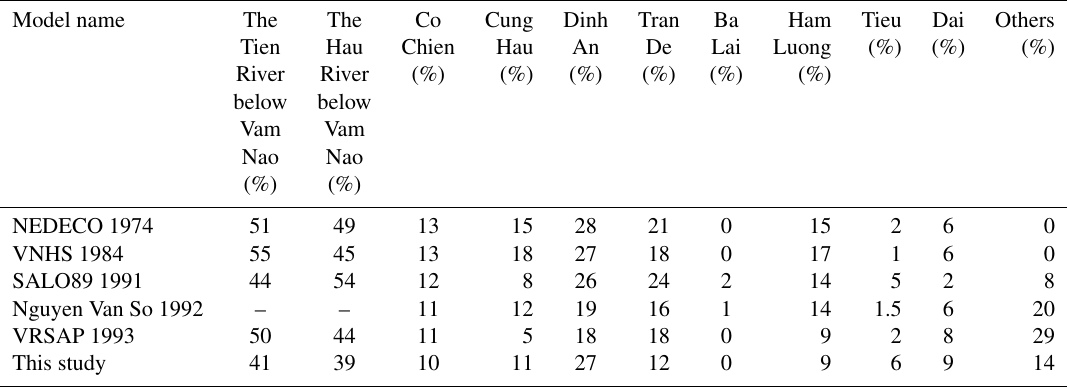
Table 3. Distribution of water discharge throughout the river mouths (following Nguyen et al., 2008). Model